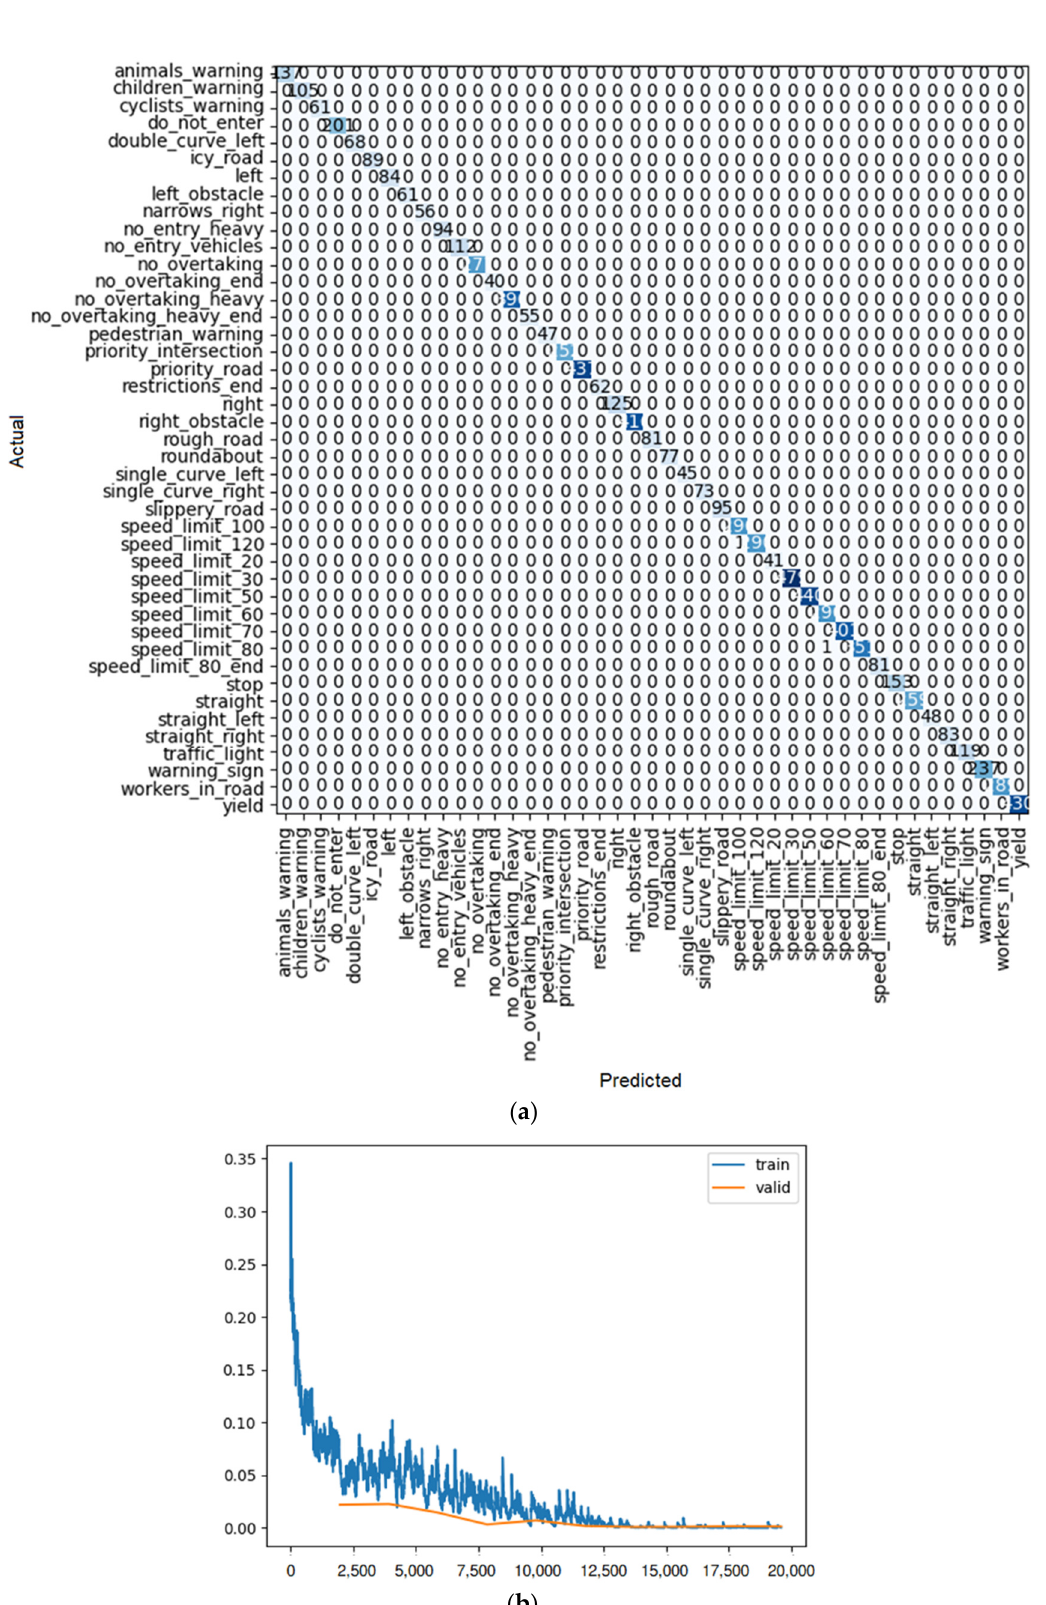
Figure 20. ( a ) Confusion matrix and ( b ) loss rate during training with DenseNet 169. Table 12. Results of the DenseNet 201.